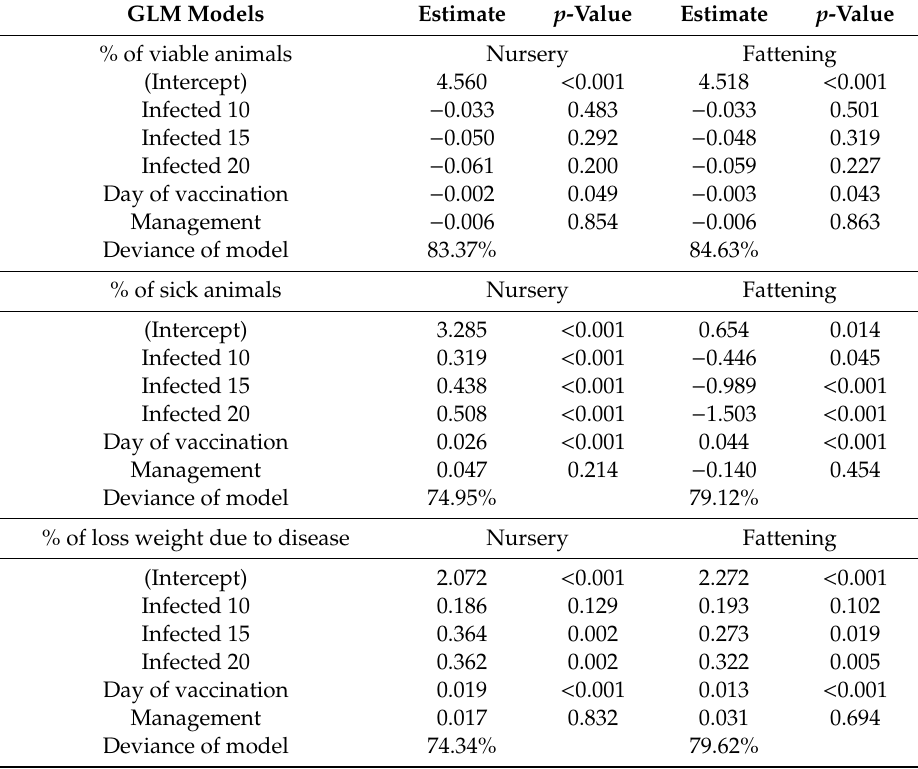
Table 3. Generalized Linear Model results. The e ff ects of the percentage of infected animals, the day of vaccination, and management regime on the percentages of viable and sick animals, and animals showing total weight loss during the nursery and fattening phase when 100% of the animals are vaccinated. Two management regimes are compared: orderly movements, in which fattening pens are filled with piglets housed together in the nursery unit according to the identity of their mother (mother management); and random movements, where piglets are assigned to the nursery and fattening pens at random (random management).